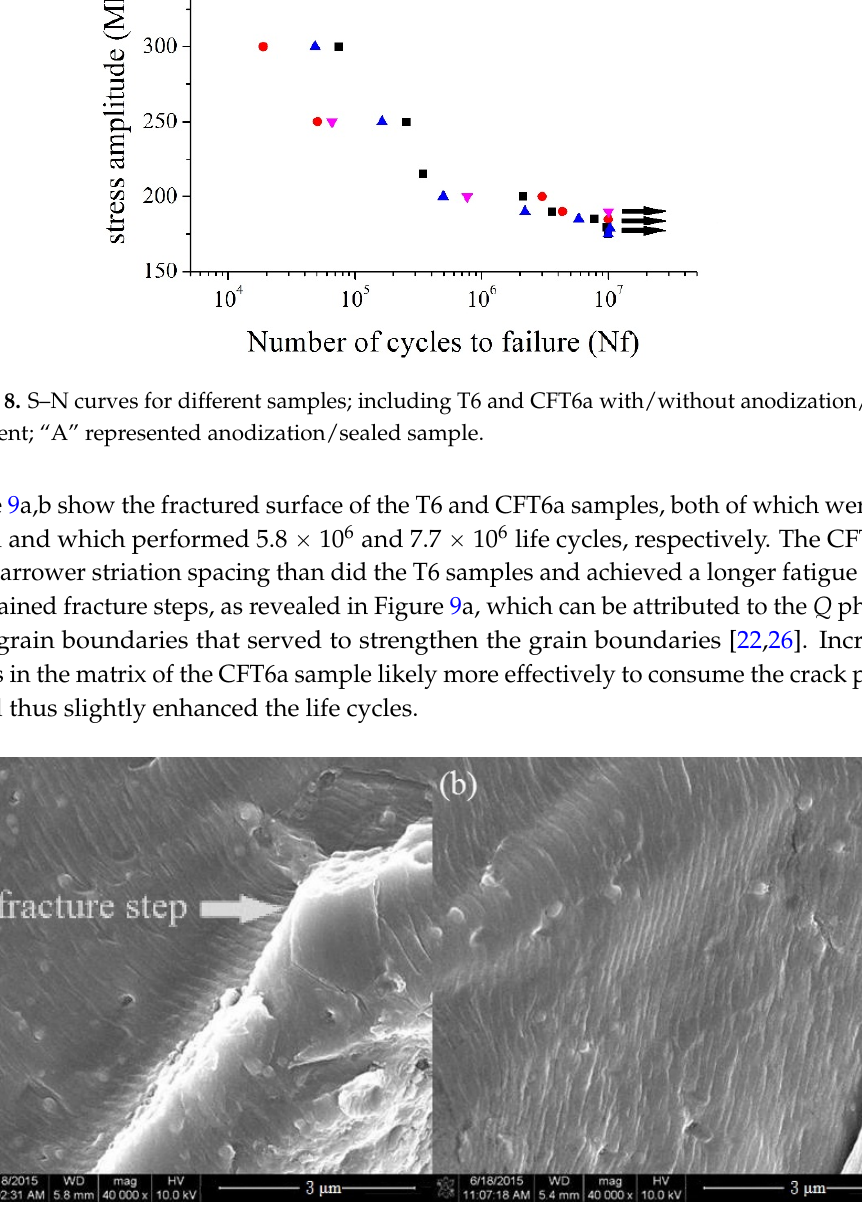
Figure 9. Fracture surface prepared from ( a ) T6; ( b ) CFT6a samples; both subjected to 185 MPa and fractured at 5.8 × 10 6 and 7.7 × 10 6 life cycles, respectively.